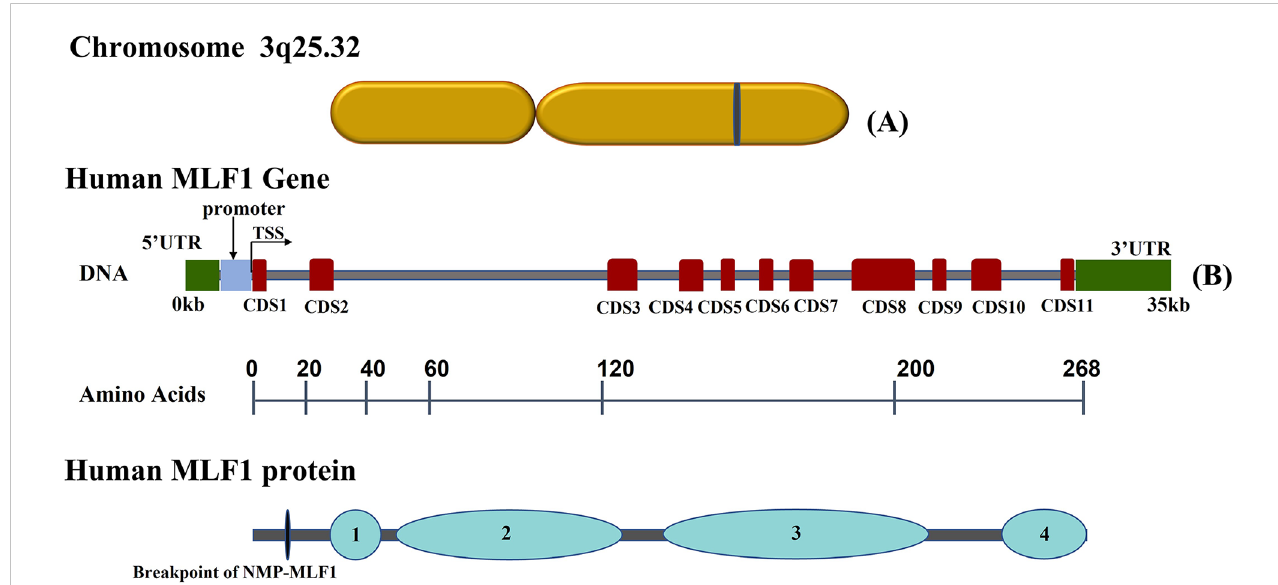
FIGURE 1 Schematic representation of human Myeloid Leukemia Factor 1 (MLF1) chromosome, gene and corresponding protein domains: (A) Diagram of MLF1 gene chromosome location. (B) The grey horizontal line represents the DNA sequence, red boxes on the sequence represent coding sequences (CDS) in MLF1, and two green boxes at the ends indicate UTRs. Underneath, the numbers over the black lines indicate the amino acid positions, which correspond to human MLF1 protein domains ([1] 14-3-3 protein binding domain (Ser34); [2] the COP9 signalosome subunit 3(CNS3) binding domain; [3] MLF family characteristic domain; [4] a SAM domain). All sequences were obtained from the NCBI